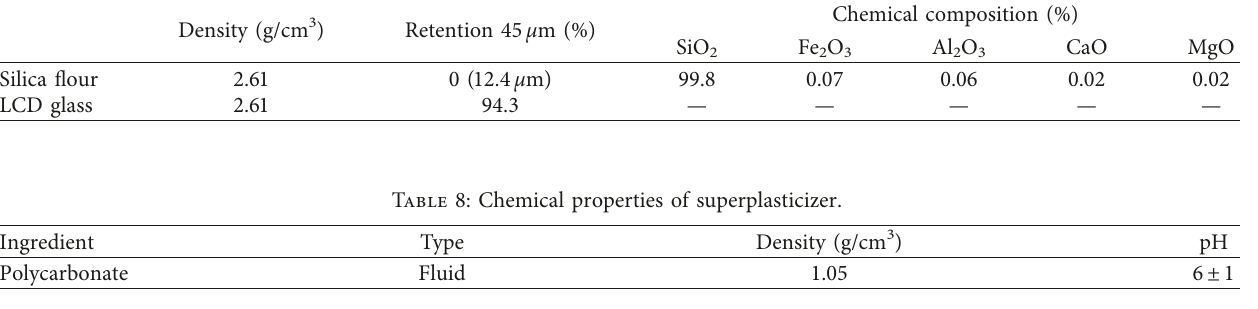
Table 7: Physical properties of filler.